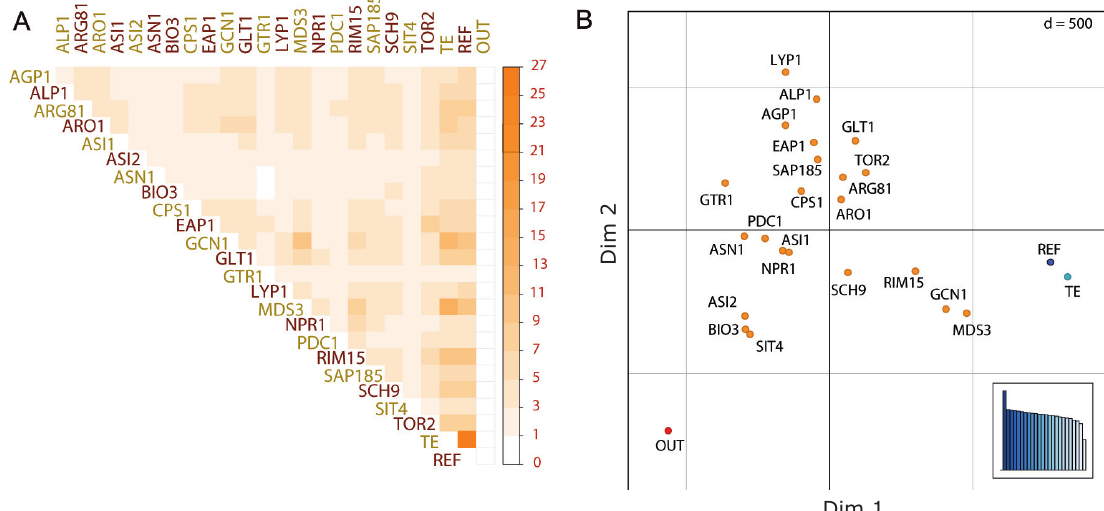
Figure 2. Comparison of tree topologies for nitrogen associated genes. ( A ) Similarity matrix comparing tree topologies between genes. The REF and TE trees were included as controls, in addition to the randomly generated OUT tree. The colour-scale goes between the minimum (0%, white) and maximum (27%, dark orange) similarities observed between individual trees. ( B ) Bi-dimensional representation of the tree spaces obtained from the topology comparison. The multidimensional scaling was performed by using the Smacof R package